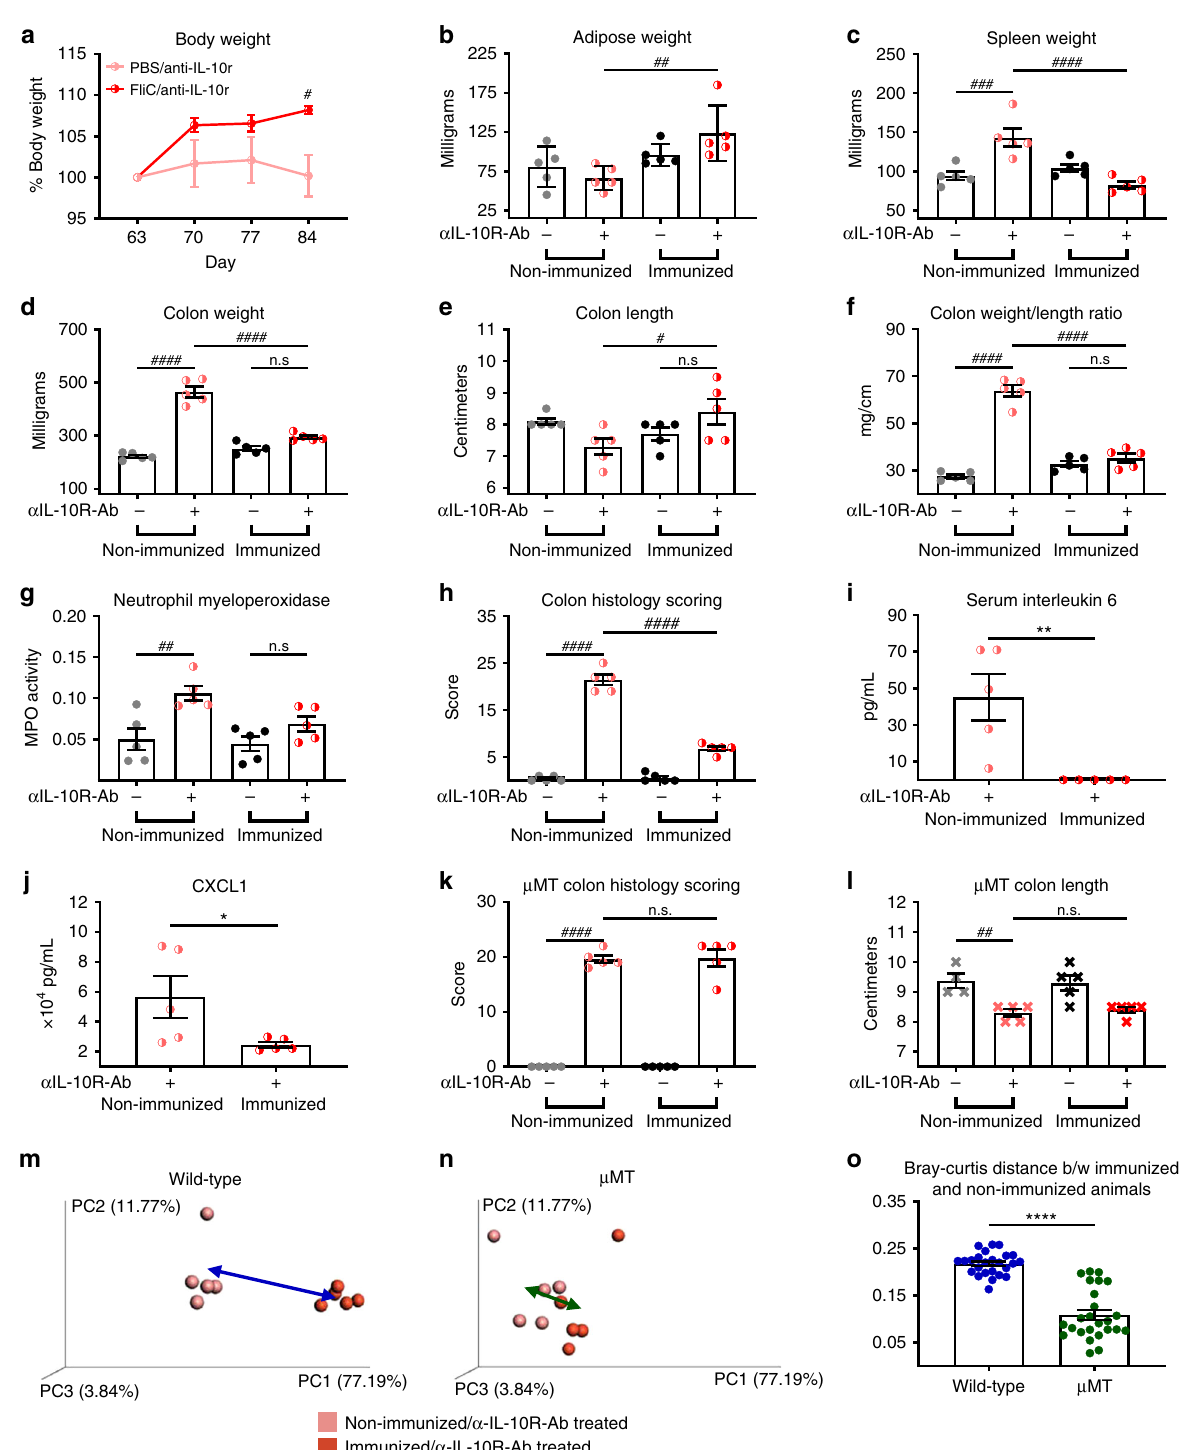
Fig. 4 Flagellin administrations protect against immune dysregulation-induced colitis. 4 – 8-week old C57BL/6 J wild-type and μ MT mice received either vehicle or 10 μ g of fl agellin by intraperitoneal injections weekly for 9 weeks. Subsequently, animals were treated weekly for 4 weeks by 1 mg of anti-IL-10R antibody intraperitoneally to induce intestinal in fl ammation. Biometric data of Wild Type animals represented by a body weight, b adipose weight, c spleen weight, d colon weight, e colon length, f and colon weight/length ratio. g Colonic myeloperoxidase levels. h Colon pathohistological scoring. i – j Serum interleukin-6 and CXCL1 following anti-IL-10R antibody regimen. Severity of colitis in μ MT animal represented by k colon pathohistological scoring and l colon length. m – o Principal coordinate analysis of the Bray – Curtis distance using a matrix containing all the morphometric and molecular parameters presented in a – l . Data are the means ± S.E.M. Signi fi cance was determined using t test (* p ≤ 0.05 ** p ≤ 0.01 **** p ≤ 0.0001) or using one-way ANOVA corrected for multiple comparisons with a Bonferroni test (# p ≤ 0.05 ## p ≤ 0.01 ### p ≤ 0.001 #### p ≤ 0.0001, n.s. indicates non-signi fi cant). ( N = 4 – 5 mice from one out of two representative experiment). Source data are provided as a Source Data fi